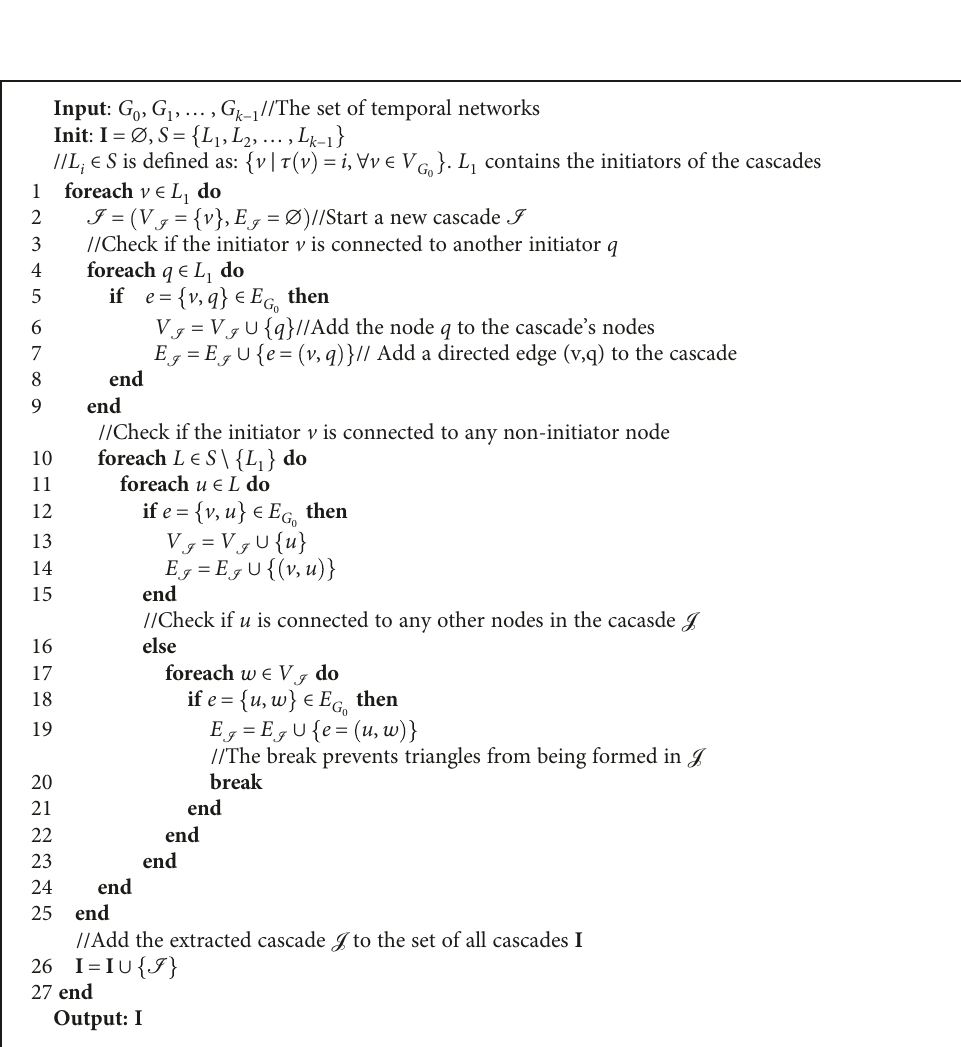
Algorithm 1: The steps for extracting inactivity cascades, I , from the set of temporal networks networks G